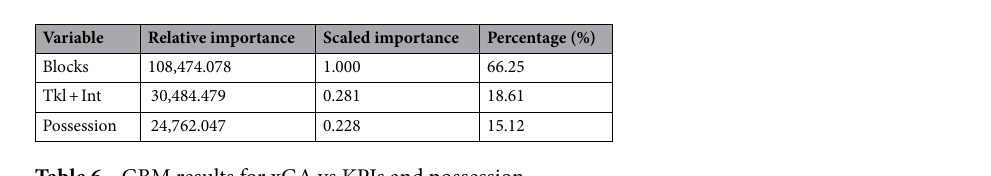
Table 6. GBM results for xGA vs KPIs and possession.